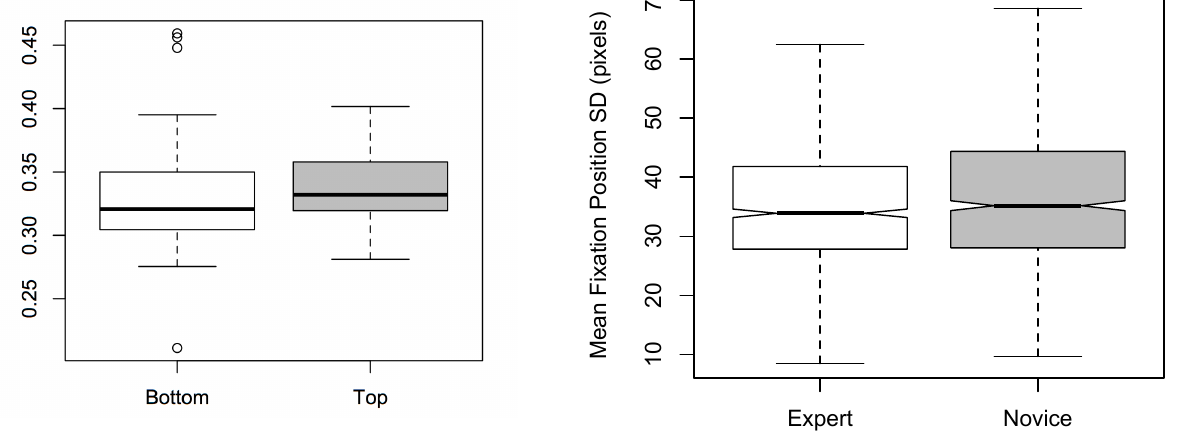
Figure 3. Boxplots of mean fixation durations for ROI (bottom and top) .